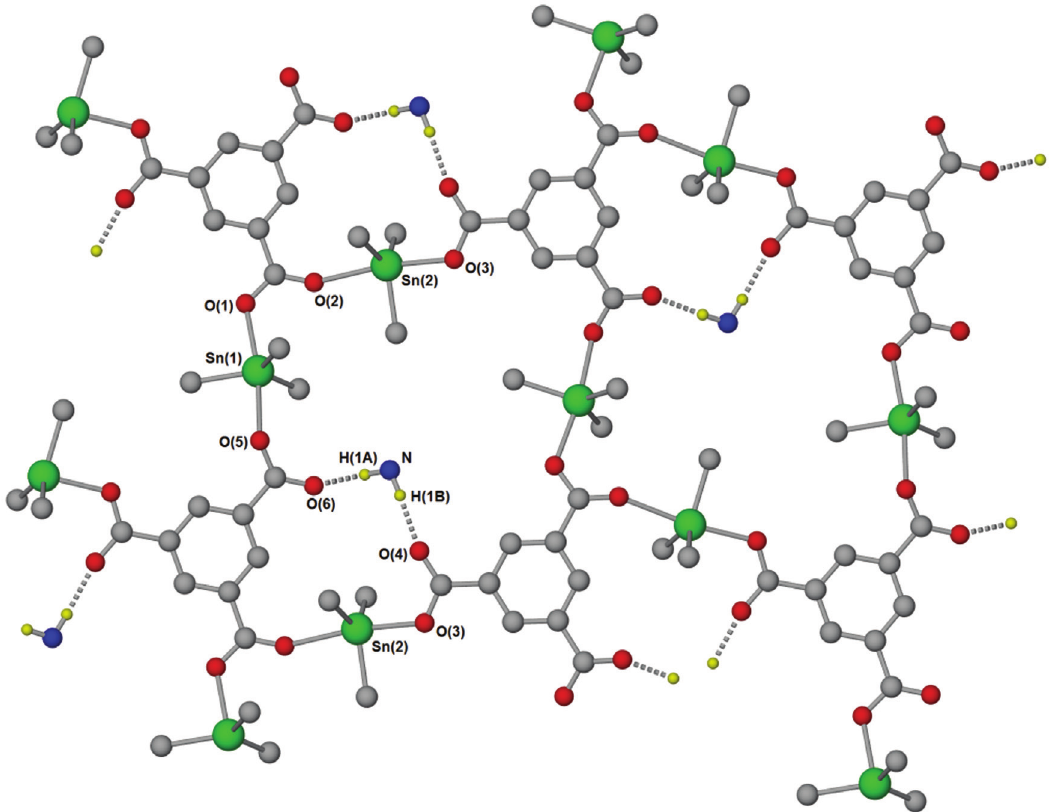
Figure 4 Lattice structure of compound 2. The isobutyl groups on nitrogen have been omitted for